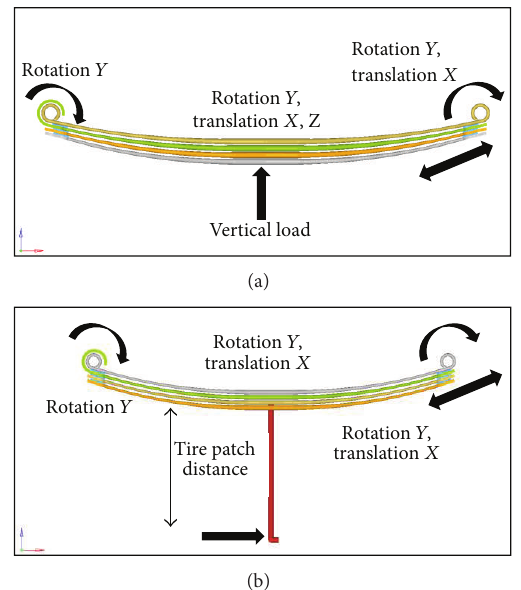
Figure 2: Boundary conditions and loads applied: (a) vertical push, (b)